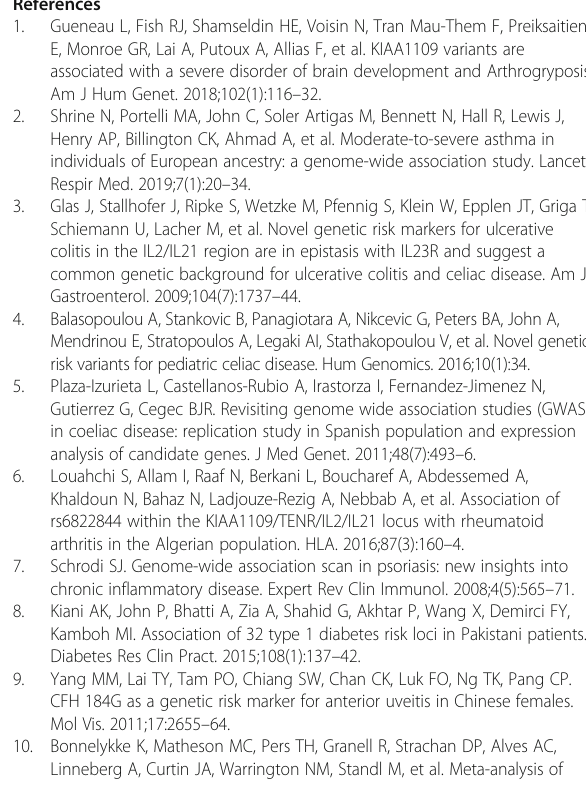
Additional file 1: Supplementary Table S1. List of qualitative rare variants identified from four patients and unaffected father of index